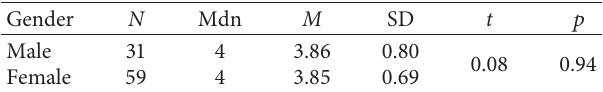
Table 4: Independent samples t -test comparing gender differences in attitude toward programming.